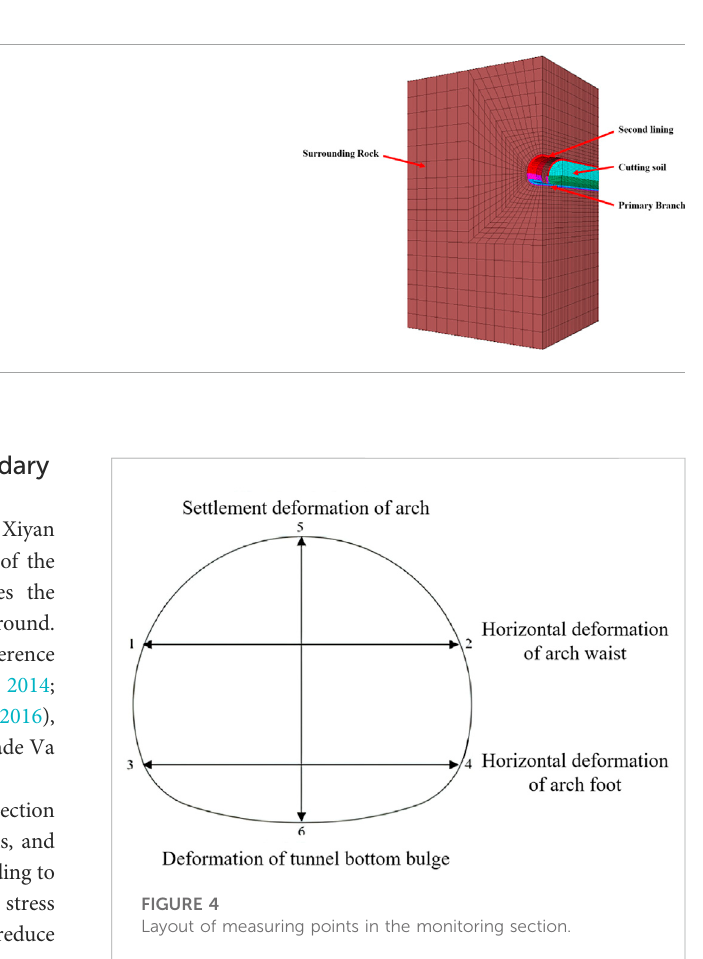
TABLE 3 FEM model meshing.